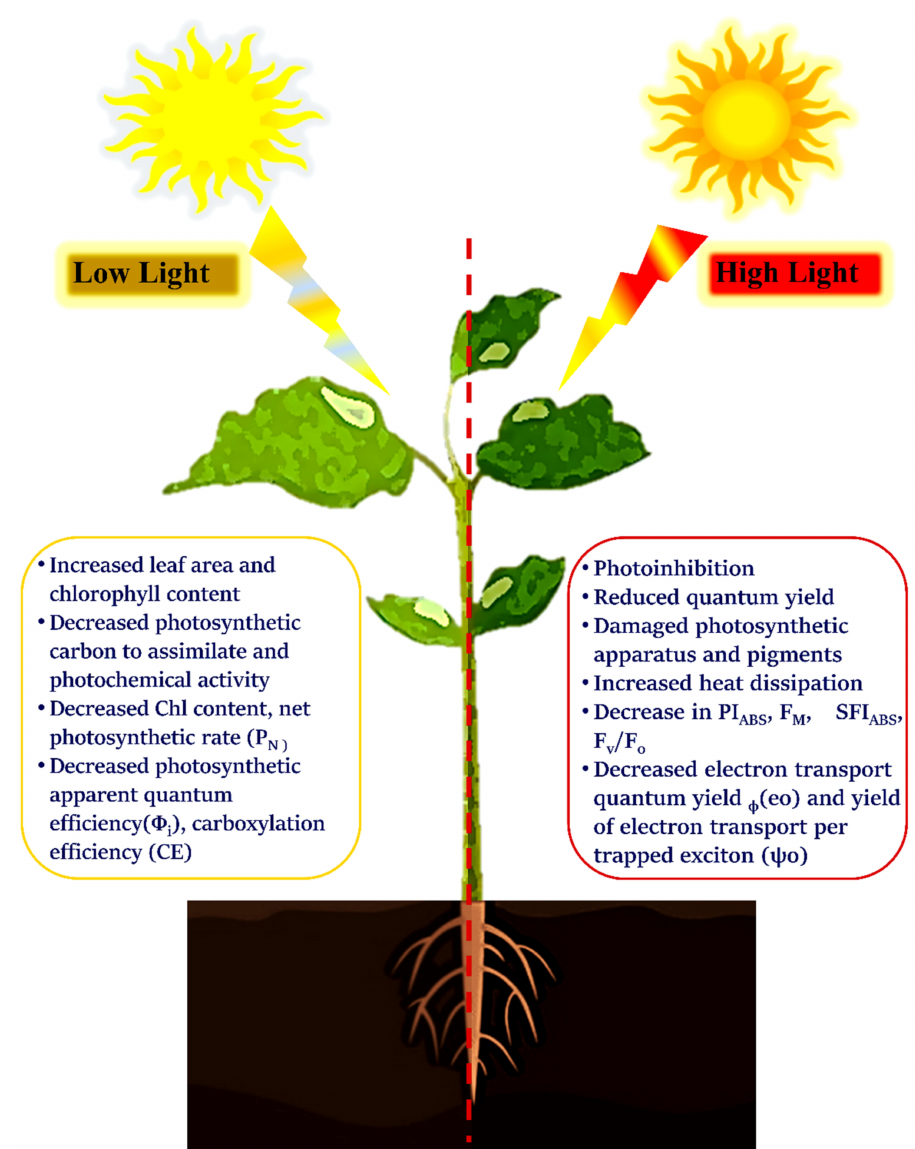
Figure 4. Effect of low and high light in the photosynthetic performance of